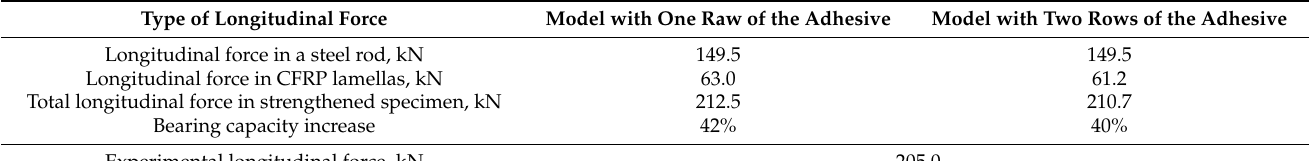
Table 8. Maximum longitudinal forces arising in strengthened specimens according to the results of numerical calculations.